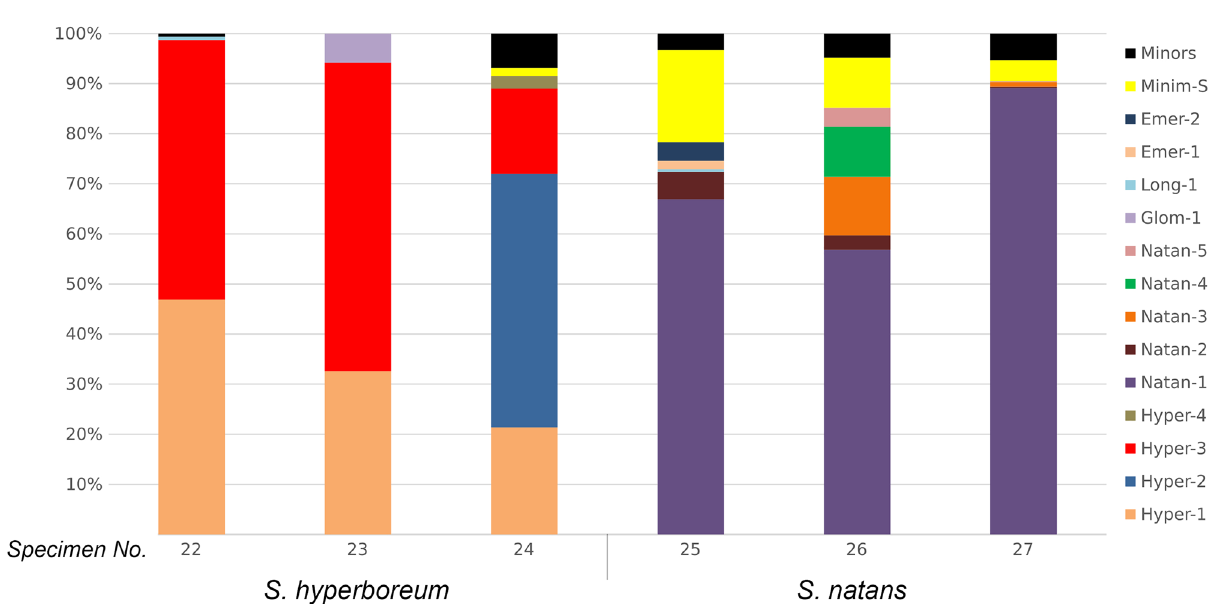
Figure 3. Stacked bar plots showing the relative abundance of the major ribotypes across the species of subgenus Xanthosparganium section Minima . Minor ribotypes in a sample are collectively termed